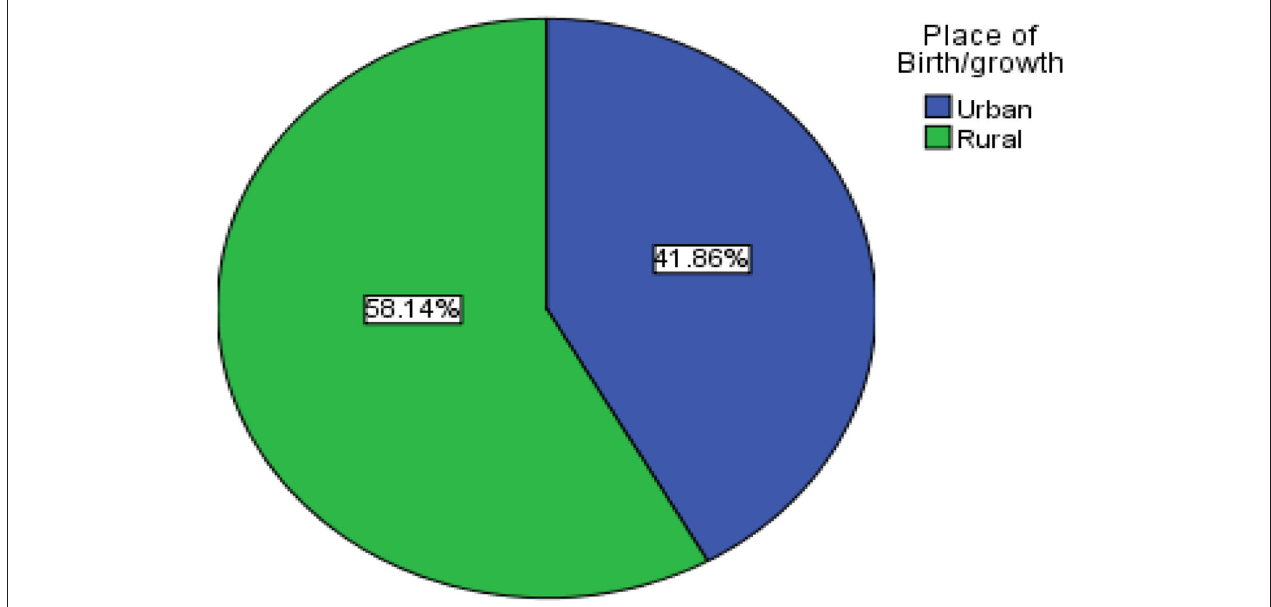
FIGURE 3 | Pie-chart of return female migrant percentage by birthplace.